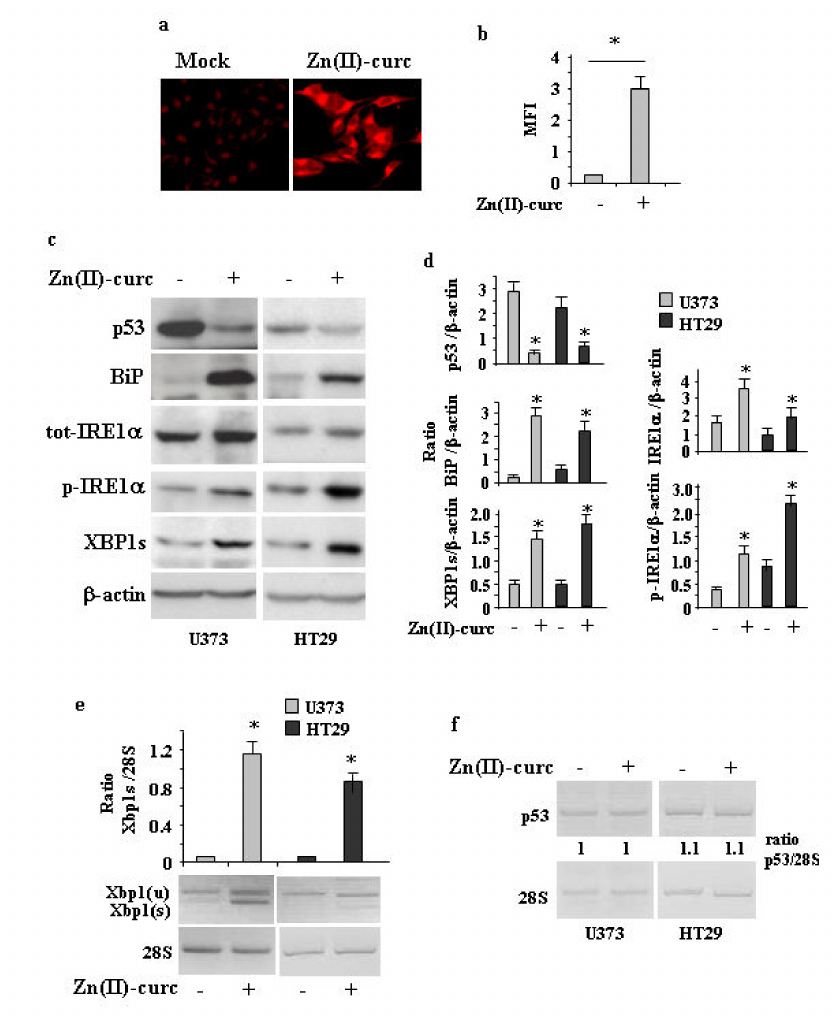
Figure 1. Zn (II)-curc induces endoplasmic reticulum (ER) stress in mutant p53H273-carrying cells. ( a ) Representative photomicrographs of ER-Red Fluorescence staining in U373 cells untreated (Mock) or treated with Zn (II)-curc (100 µ g / mL) for 16 h (Original magnification: 40 × ). ( b ) Quantization of ER content in U373 cells from ER-Red Fluorescence-stained cells. Mean fluorescence intensity (MFI) of each individual cell was normalized to cell size and expressed as fold-change compared with untreated cells at the same time point. Histograms represent the mean ± SD of three independent experiments. * p ≤ 0.05. ( c ) Western blot analysis of p53, BiP, total (tot) IRE1 α , phosphorylated (p) IRE1 α , and XBP1 spliced (s) protein levels evaluated in U373 and HT29 cells untreated or treated with Zn (II)-curc (100 µ g / mL) for 24 h. ( d ) Densitometric analysis was performed using Image J software to calculate the ratio of the protein levels, as detected in ( c ), vs. β -actin. Histograms represent the mean ± SD of three independent experiments. * p ≤ 0.05. ( e ) Total mRNA was extracted from U373 and HT29 cells untreated or treated with Zn (II)-curc (100 µ g / mL) for 24 h. Spliced (s) Xbp1 gene expression was assayed by the polymerase chain reaction (PCR) of reverse-transcribed cDNA. Densitometric analysis was performed using Image J software to calculate the Xbp1s / 28S ratio. Histograms represent the mean ± SD of three independent experiments. * p ≤ 0.05. ( f ) p53 gene expression was assayed by PCR as in ( e ). The p53 / 28S ratio is